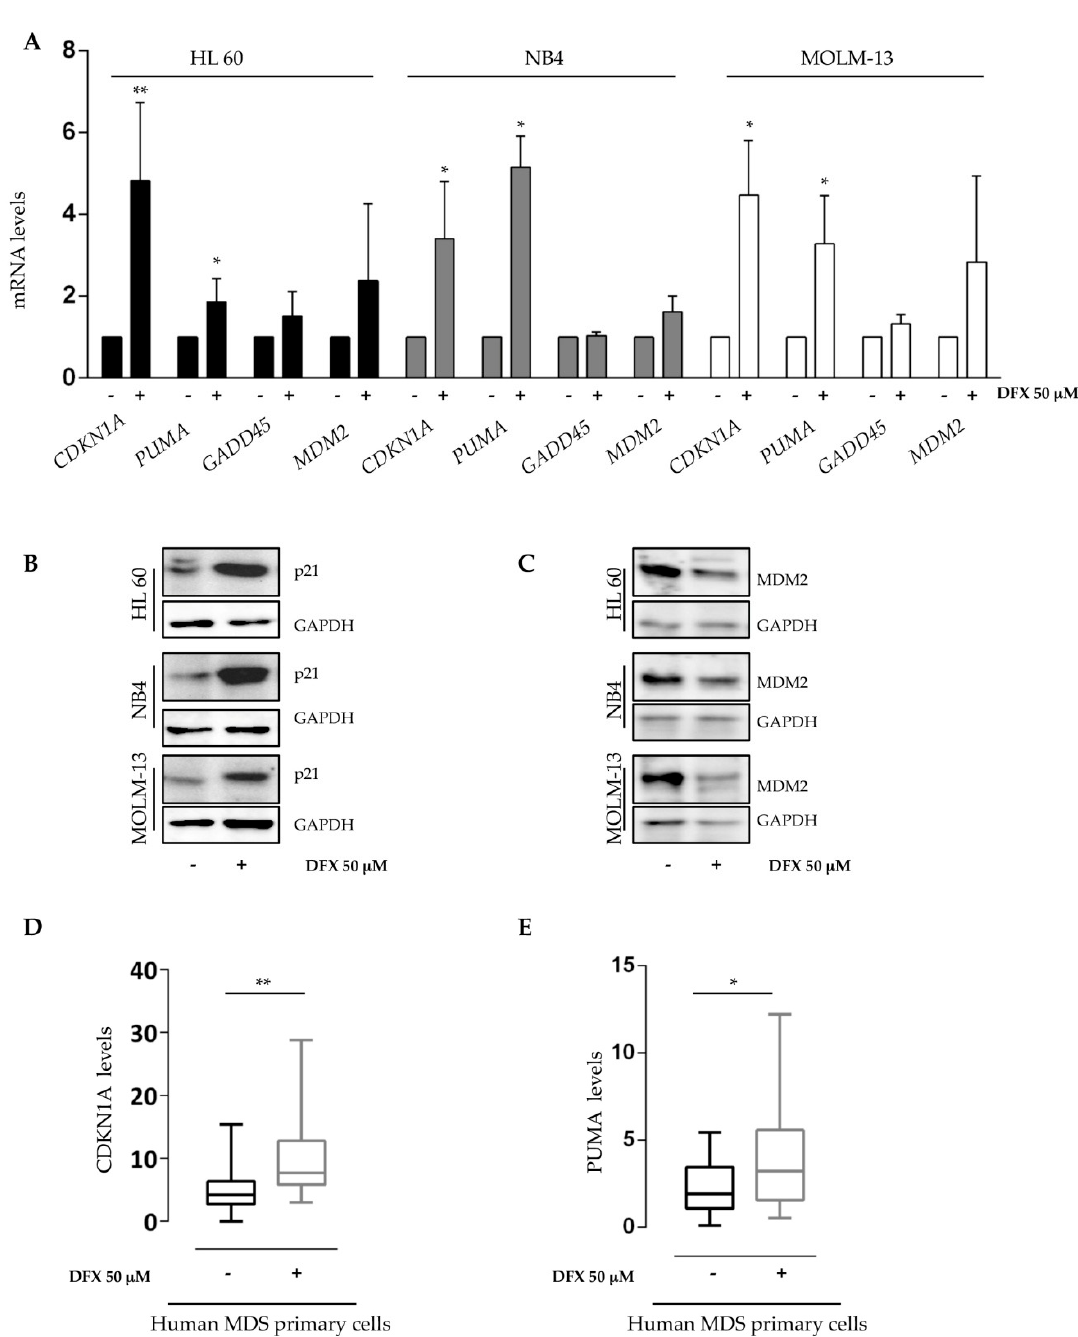
Figure 3. Deferasirox activates p53 targets on acute myeloid leukemia cell lines and MDS / AML patients. ( A ) CDKN1A , PUMA , GADD45 , and MDM2 gene expression were assayed by qRT-PCR in HL60, NB4, and MOLM-13 after 48 h treatment with DFX 50 µ M. The amount is expressed as fold changes compared to untreated cells after normalizing on the ABL housekeeping gene. ( B , C ) Western blot analysis of target proteins p21 and MDM2 after iron chelation treatment confirmed the e ff ects of DFX on the p53 pathway. ( D , E ) CDKN1A and PUMA gene expression was assayed by qRT-PCR on 15 patients’ cells after 48 h in vitro treatment with DFX 50 µ M. The mRNA quantity is expressed as 2 − ∆∆ Ct after normalization with the ABL housekeeping gene. Abbreviations: -, not treated; + treated with DFX 50 µ M; DFX, Deferasirox. * p ≤ 0.05, ** p ≤ 0.01.